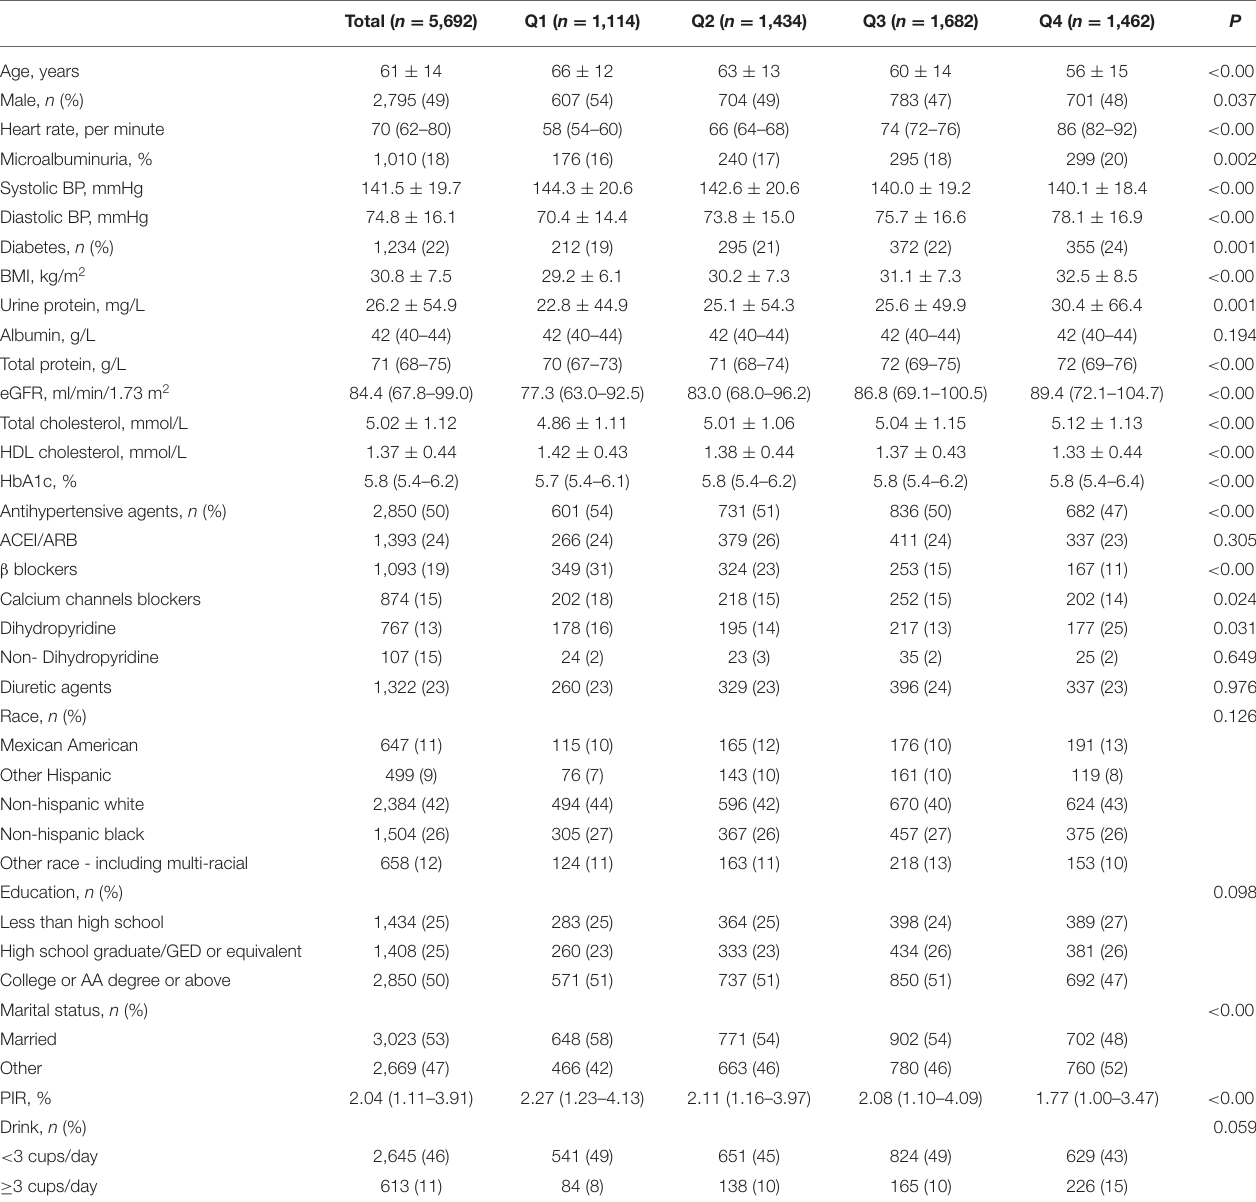
TABLE 1 | Characteristics of